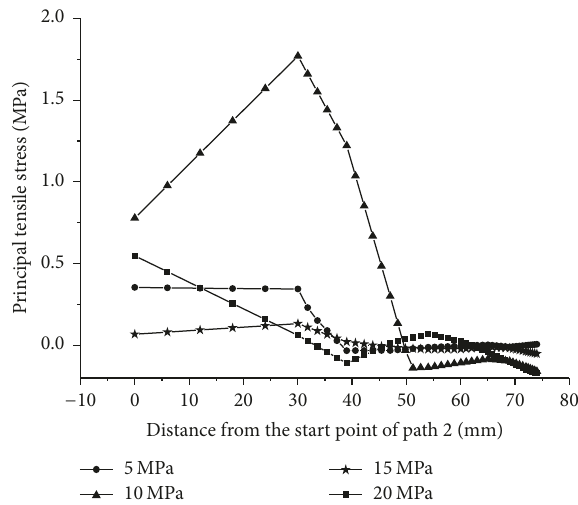
Figure 24: Comparison of the principal tensile stress generated along path 2 from corrosion-induced expansion when the dis- placement resulting from corrosion-induced expansion reaches 0.022 mm.